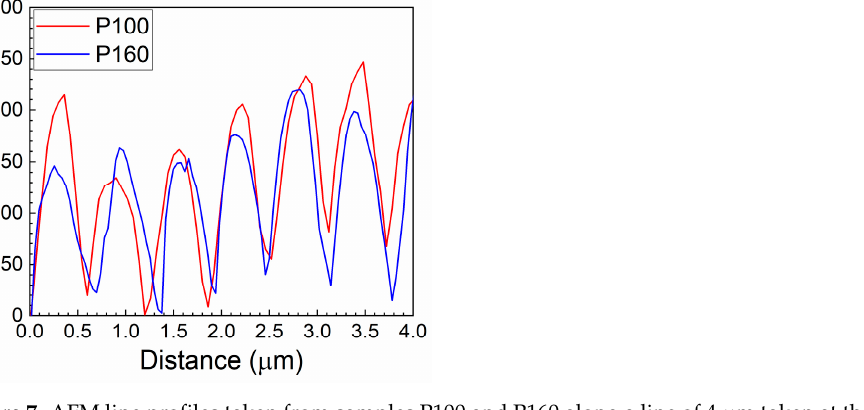
Figure 7. AFM line profiles taken from samples P100 and P160 along a line of 4 µ m taken at the centre of the images shown in Figure 6b,d, respectively.